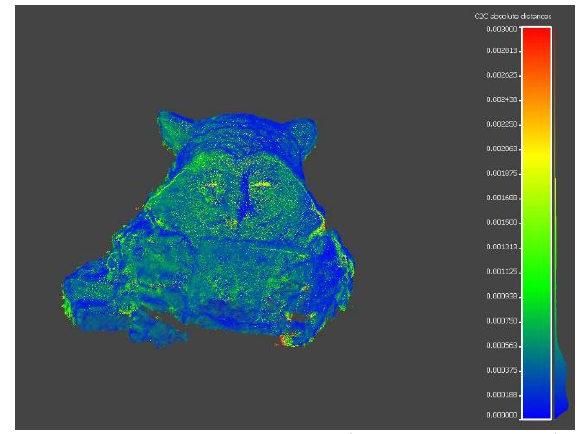
Table 1: Measured sizes per method